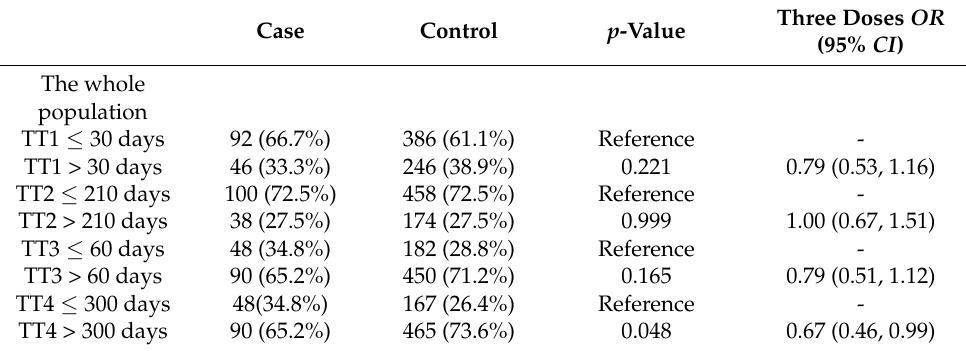
Table 5. The association between vaccination intervals and SARS-CoV-2 infection among those who received three vaccine